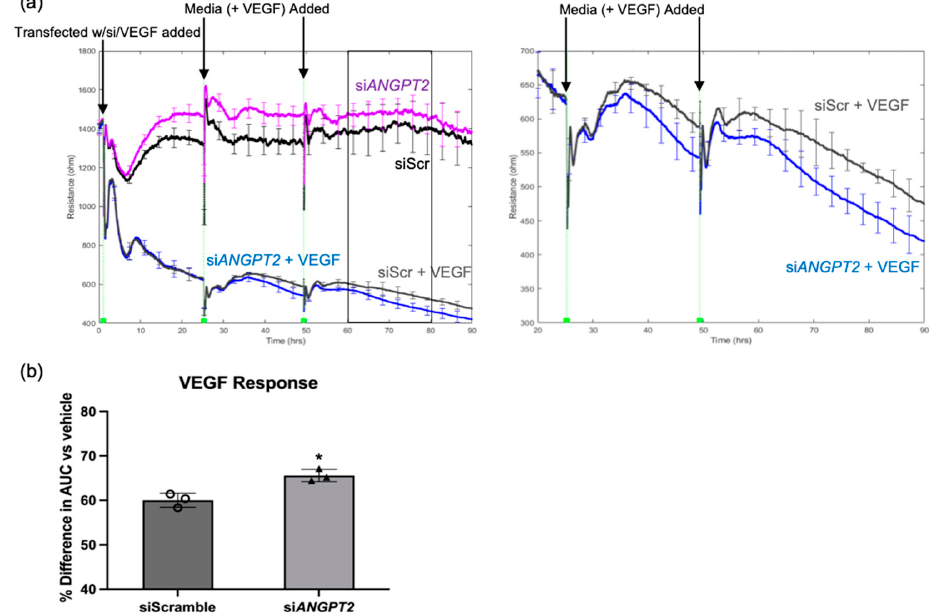
Figure 6. Ang2 limited the extent of VEGF-induced permeability. ( a ) Electric cell-substrate impedance sensing (ECIS) of confluent monolayers of normal-glucose HRECs was measured briefly before transfection with siScramble or si ANGPT2 (10–15 nM) with simultaneous treatment with VEGF (2 nM) or vehicle (PBS). Resistance is presented in ohms. Transfection media was removed at 24 h and replaced with fresh media containing VEGF or vehicle. The box represents the time period used for area under curve (AUC) calculation. ( b ) The percent difference in the resistance AUC for HRECs transfected with siScramble or si ANGPT2 and simultaneous VEGF stimulation. Percent difference was calculated relative to HRECs that received VEGF vehicle (PBS) with respective siRNA. AUC was calculated for the period 60–80 h after transfection and VEGF stimulation. Similar results are observed in at least three independent experiments. Data are expressed as mean ± SD. * p < 0.05 vs. PBS. n = 3 to 4 wells per